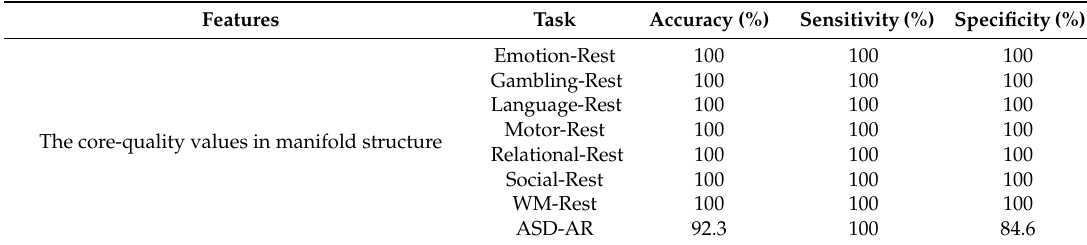
Table 1. The eight linear SVM classifiers’ accuracy with a leave-one-out cross-validation strategy for the seven tasks and the resting state, the ASD’s and AR’s resting states with the manifold structure. Sensitivity accuracy is the accuracy of emotion, gambling, language, motor, relational, social, and WM tasks and the ASD resting state. The specificity accuracy is the accuracy of the resting state and AR resting state.